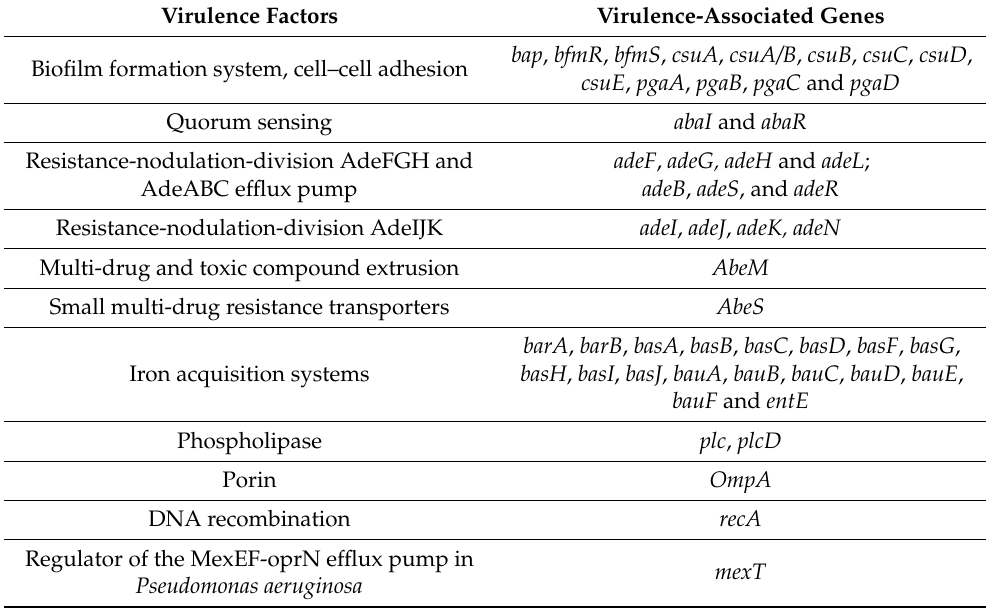
Table 4. Virulence-associated genes investigated using whole-genome